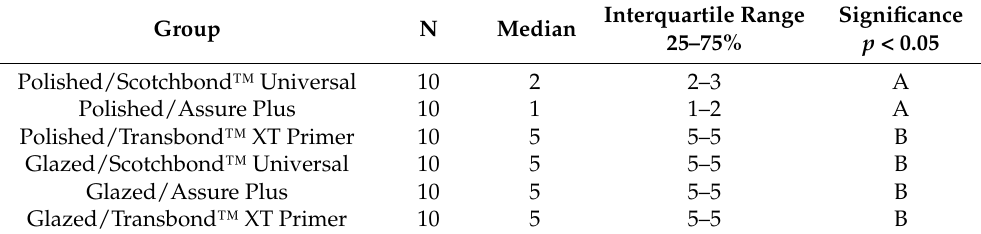
Table 6. Descriptive statistics of ARI scores for monolithic zirconia